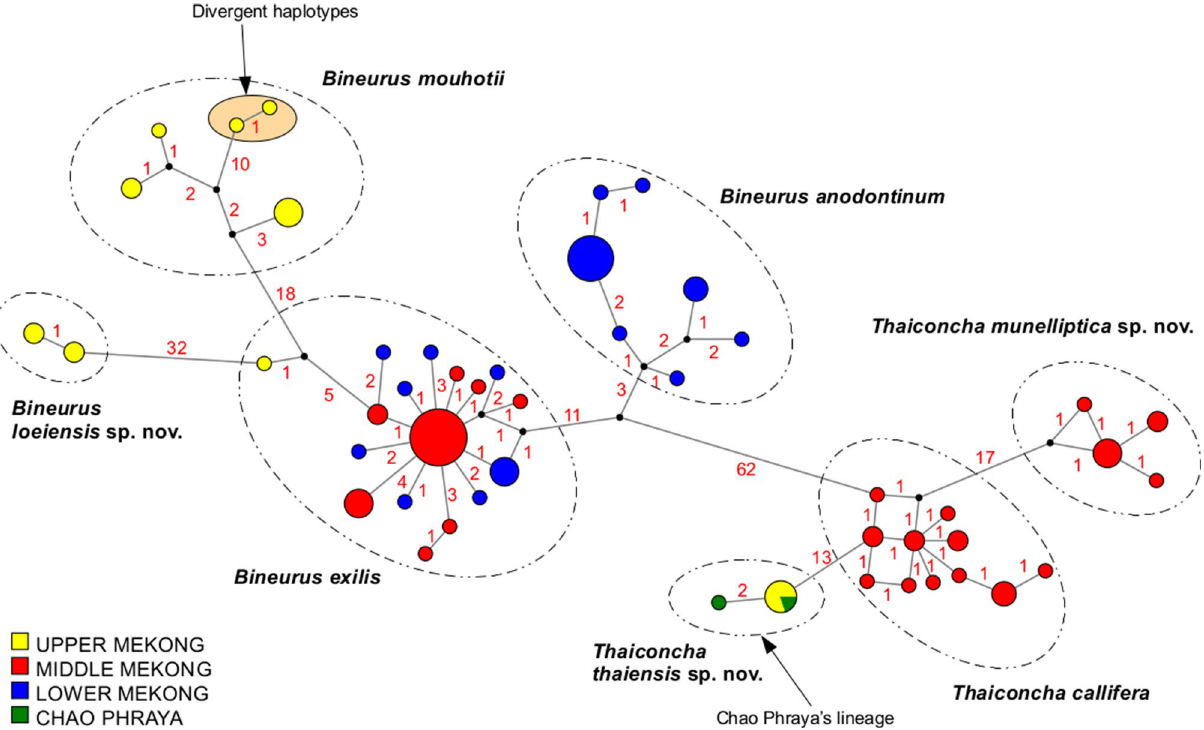
Figure 5. Median joining network of the COI sequences of Bineurus and Thaiconcha species ( N = 102). The red numbers near branches indicate the numbers of nucleotide substitutions between haplotypes. Size of circles corresponds to the number of available sequences for each haplotype (smallest circle = one sequence). The Mekong was divided into sections based on Halls and Kshatriya 21, 22 .